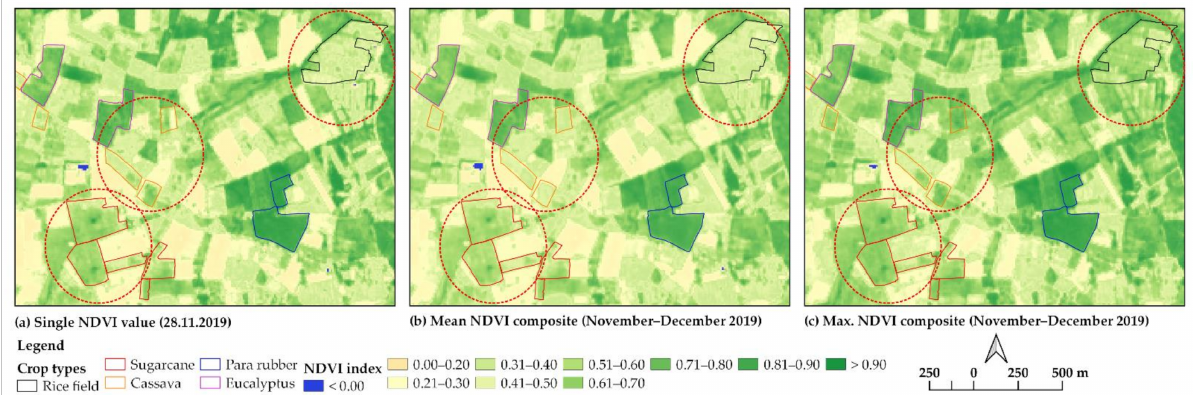
Figure 19. Comparison of single ( a ), mean ( b ), and max. NDVI ( c ) pixel values of Sentinel-2 (S2) image data (November– December 2019) with 10 m of spatial resolution. These data (cloud cover < 40%) were acquired for the Udon Thani province,